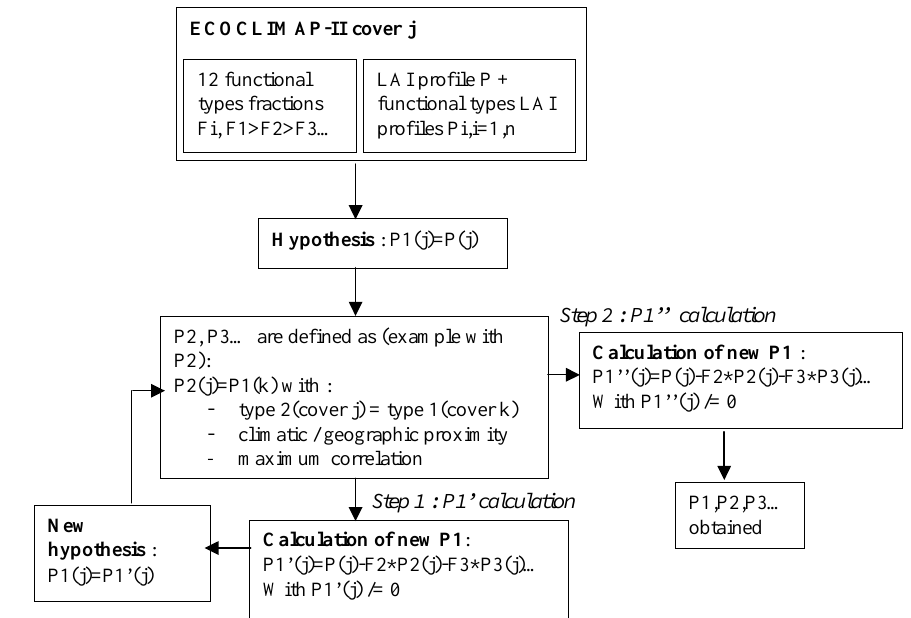
Fig. 5. Disentanglement of LAI profiles from covers to functional types. P :LAI profile F : functional type fraction.